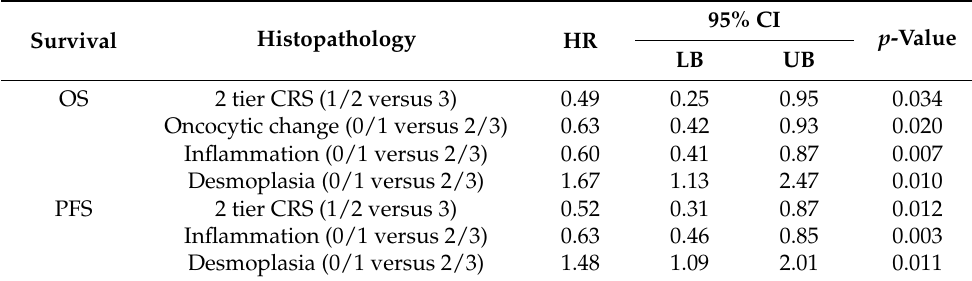
Table 3. Multivariate survival analysis by prognostic